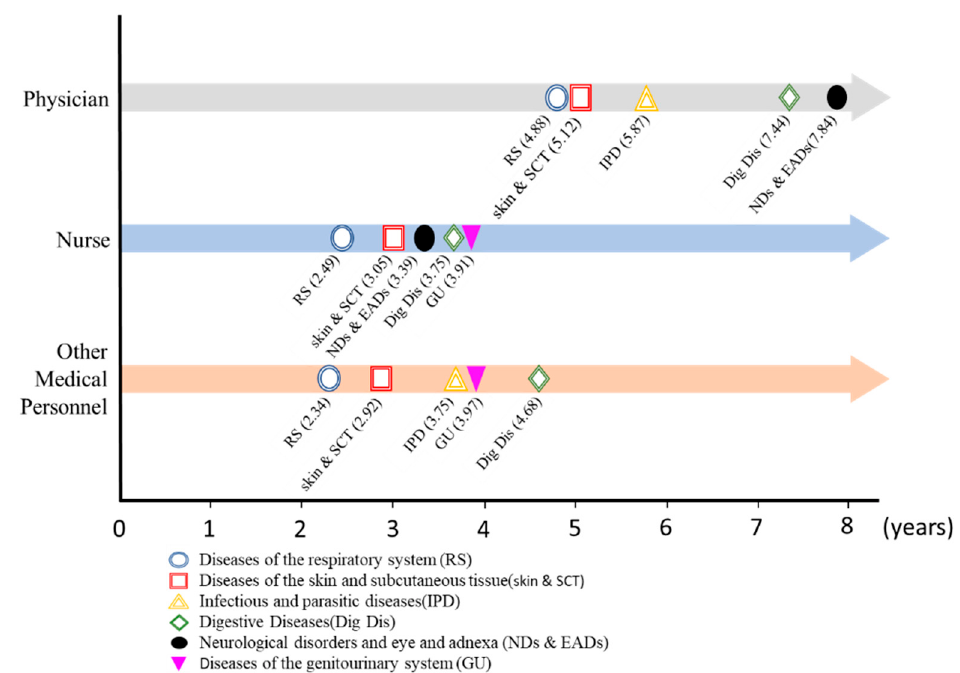
Figure 1. Time between beginning of career and development of systemic diseases among medical professionals in Taiwan. professionals in